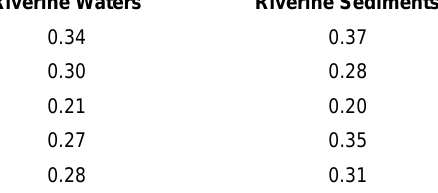
Mean Values of the ARI Calculated among Mesophilic Aeromonas spp. Isolated from Riverine Waters and Sediments Aeromonas